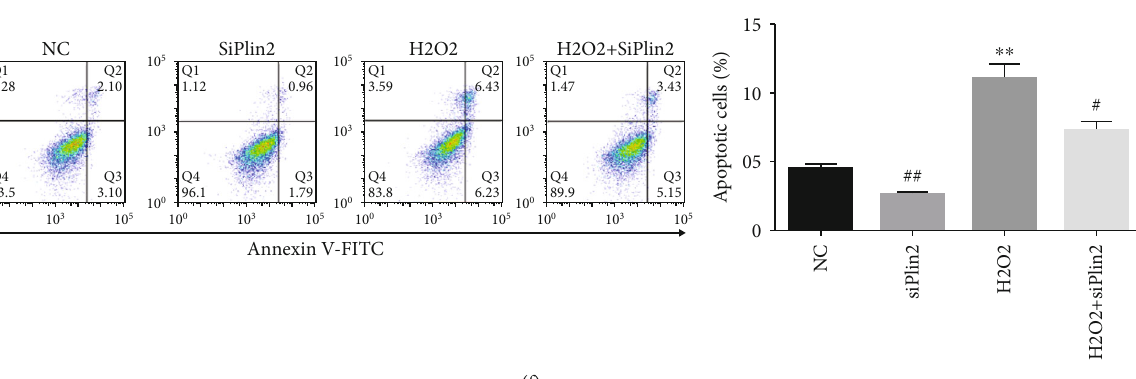
Figure 3: Knockdown of Plin2 attenuates apoptosis in primary renal proximal tubular cells. (a) Western blot analysis of Plin2 expression after Plin2 knockdown ( n = 3 ). ∗ P < 0 : 05 vs. the NC group. (b) Cell viability measured using CCK8 assays ( n = 15 ). ∗ P < 0 : 05 vs. the NC group, # P < 0 : 05 vs. the NC or H O group. Data are presented as mean ± SEM . (c) Images of mitochondrial reactive oxygen species 2 2 (ROS) generation in PTECs transfected with Plin2 knockdown plasmid after hydrogen peroxide (300 μ M) treatment. (d, e) Western blot analysis of Plin2 ( n = 3 ) and cleaved caspase-3 ( n = 4 ) expression in primary renal proximal tubular cells transfected with Plin2 knockdown plasmid after hydrogen peroxide (300 μ M) treatment ( n = 4 ). ∗ P < 0 : 05 vs. the NC group, ∗∗∗ P < 0 : 001 vs. the NC group, # P < 0 : 05 vs. the NC or H O group, and ## P < 0 : 01 vs. the NC or H O group. (f) Cell apoptosis in hydrogen peroxide (300 μ M)-treated 2 2 2 2 renal proximal tubular cells transfected with Plin2 knockdown plasmid or control plasmid. Annexin V-positive cells were considered apoptotic cells ( n = 4 ). ∗∗ P < 0 : 05 vs. the NC group, # P < 0 : 05 vs. the H O group, and ## P < 0 : 01 vs. the NC group. Data represent the 2 2 mean ± SEM . H O : hydrogen peroxide; NC: negative 2 2